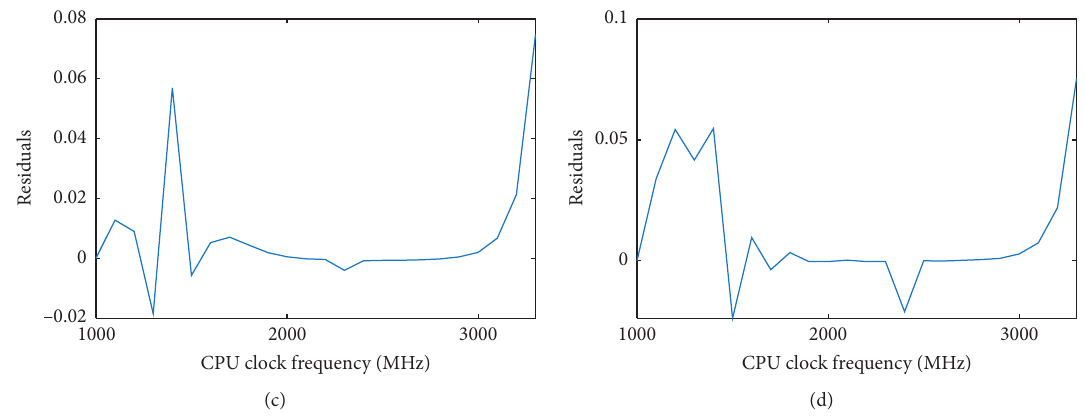
Figure 13: System 2: residuals for the predicted lates for f (c) 15MHz bandwidth. (d) 20 MHz bandwidth.